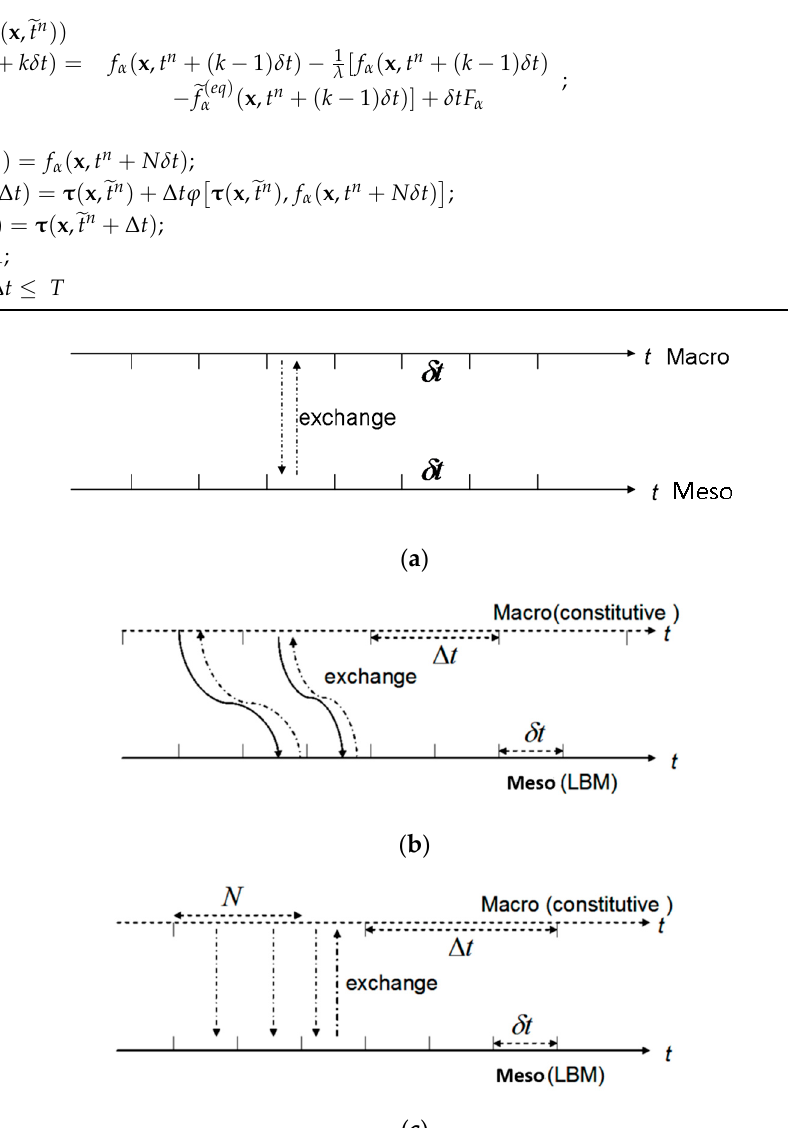
Figure 1. Schematically of time coupling. ( a ) The fully coupled (FC) method; ( b ) The asynchronously coupled (AC) method; and ( c ) The generalized asynchronously coupling (GAC) method.